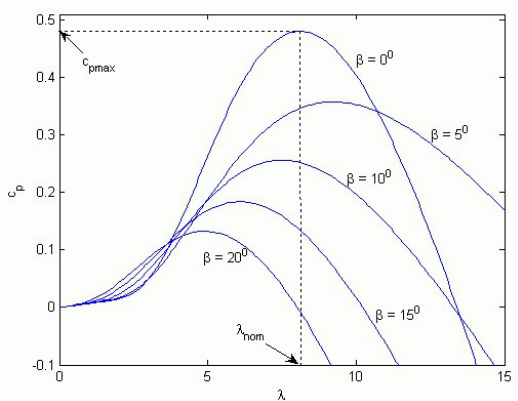
Figure 3. Characteristics of Power coefficient versus Tip speed ratio for different blade pitch angles.